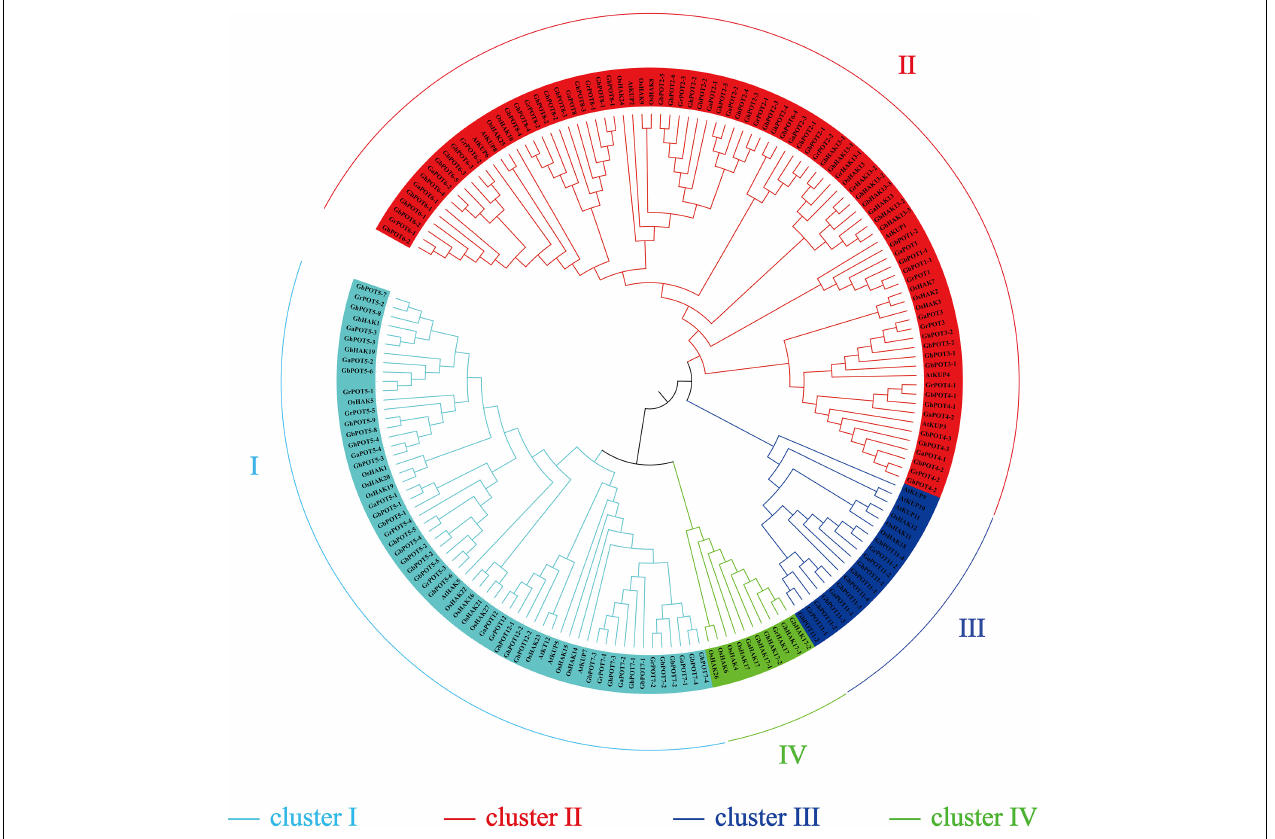
FIGURE 1 | Phylogenetic tree of HAK/KUP/KT proteins. The predicted sequences from O. sativa (27), A. thaliana (13), G. raimondii (24), G. arboretum (21), G. hirsutum (45), and G. barbadense (44) were aligned with ClustalX 2.0, and MEGA 6.0 was used to construct the phylogenetic tree by the neighbor-joining (NJ)